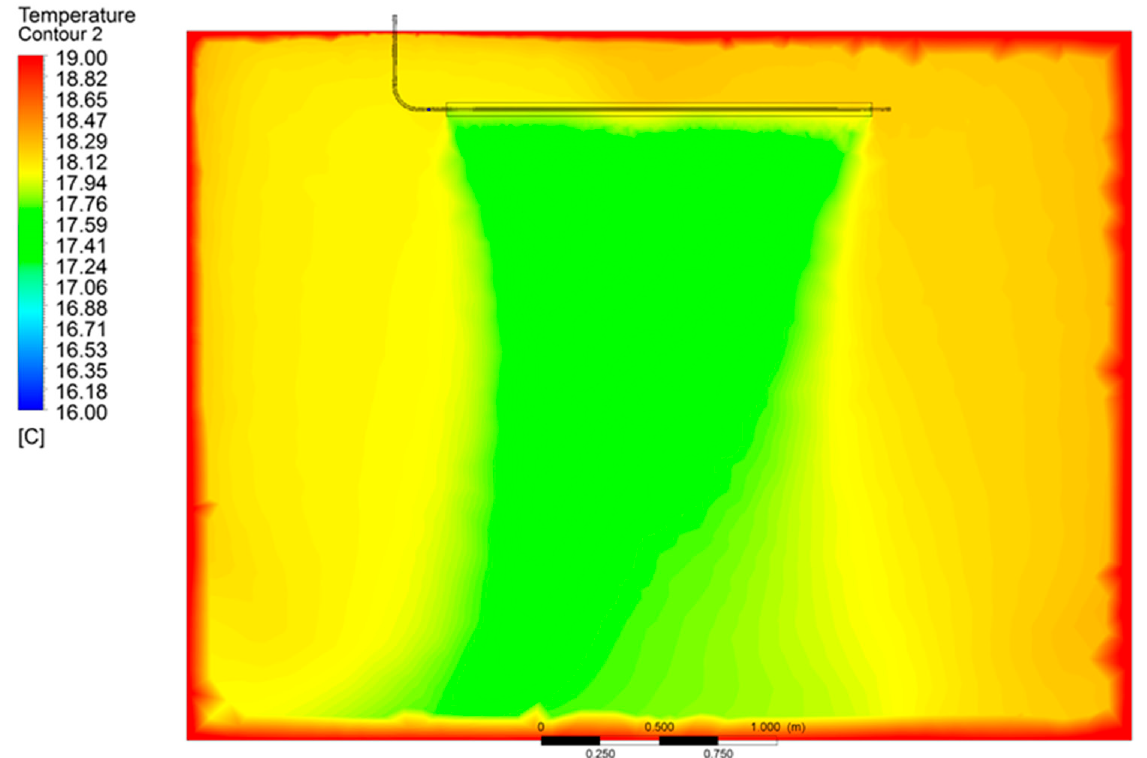
flow and temperature for a passive cooling beam. For comparison, the temperature field of a thermovision and CFD model were analyzed to follow the conformity to cooling under a stream of air convectors where the temperature distribution had the same funnel shape. This correlation allowed us to conclude that CFD methods are appropriate means for modeling natural convection and the air flow behavior of the convector. It should be noted, however, that, for the simulation of entire passive cooling convectors, the real dimensions place high demands on computer performance. The results of the mathematical simulations of the boundary layer in the intercostal space of a passive cooling beam show that the changes in rib spacing and rib height are affected by the layer, which affects the transport of heat from the cooling water to the environment and, thus, the overall cooling power of the passive cooling beam. The results of the simulations can be used to determine the optimal size and spacing of ribs to maximize the cooling performance of a passive cooling beam. In the simulations of cooling power depending on the design parameters (the spacing of the ribs, rib height and thickness, and diameter and number of tubes), for a temperature gradient of 16/19 °C, it was found that the various parameters affected the cooling power of the passive cooling beam. The simulation results clearly show that changing the spacing of the ribs has the greatest effect on the cooling power. In the simulations of the percentage change in the cooling power in response to variations in the flow rates for a given temperature gradient, it was found that better flow could be achieved by increasing the cooling power of the cooling convector. A similar dependence was calculated for a constant flow of coolant when changing the temperature gradient. 9. Limitations of the Work From the results of the simulations, it is observed that the created mathematical model works with a certain deviation, which can be compensated for with a constant of 1.53 for Δ T = 7.5 K and 1.16 for Δ T = 8 K. The difference between the correction factors could be caused by various influences that cannot be included in the simulation